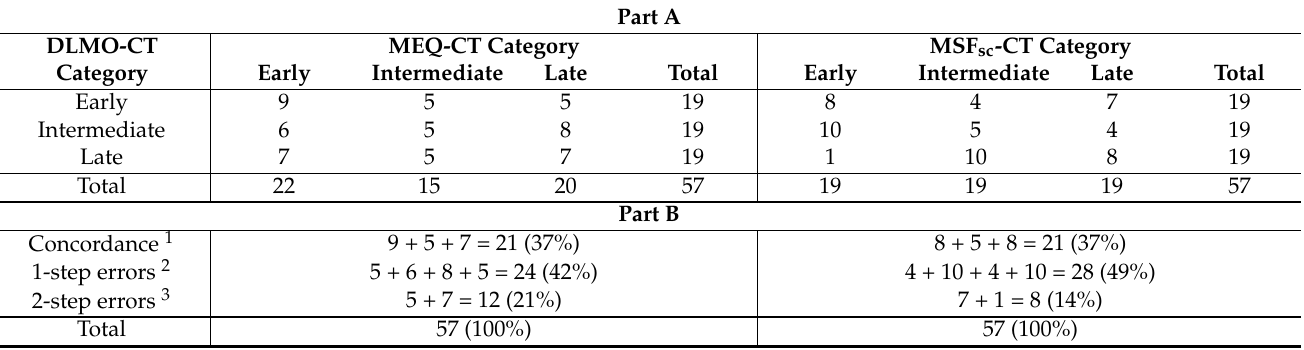
Table 3. Part A : Number of participants in each DLMO-CT and MEQ-CT category combination and each DLMO-CT and MSF sc -CT category combination. Part B : Number (percentage) of concordances, 1-step errors and 2-step errors between DLMO-CT and MEQ-CT categorisations and between DLMO-CT and MSF sc -CT